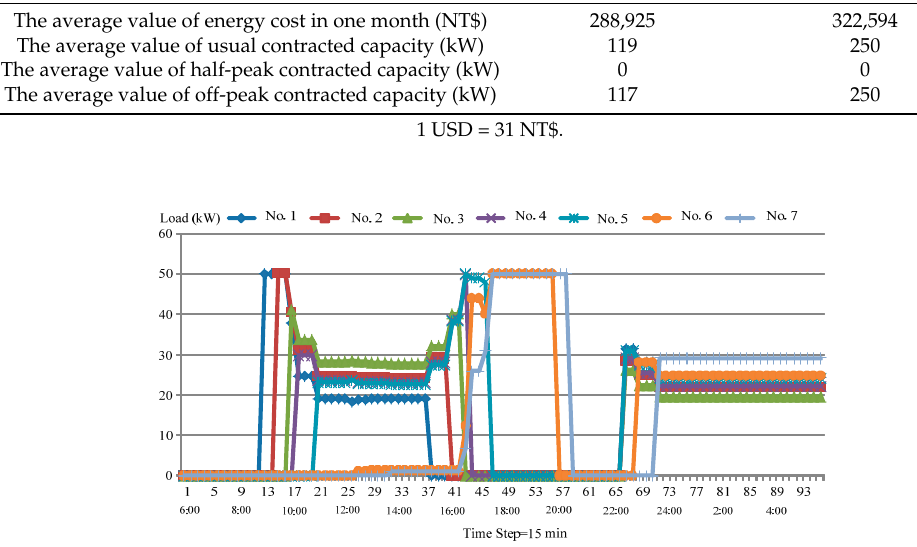
Table 3. Controlled charge and uncontrolled charge planning results for 1000 iterations.